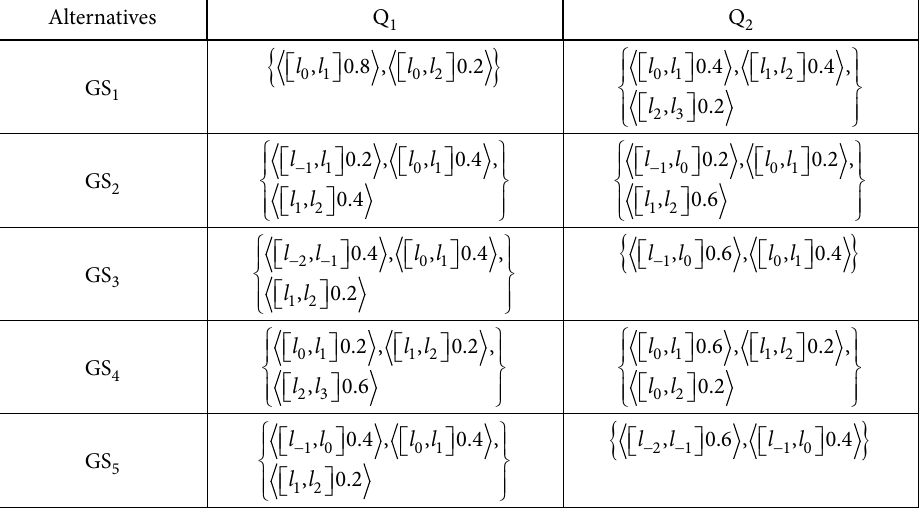
Step 2. Convert the ULTSs into PULTSs (See Table 11). Table 11. Decision matrix with PULTSs